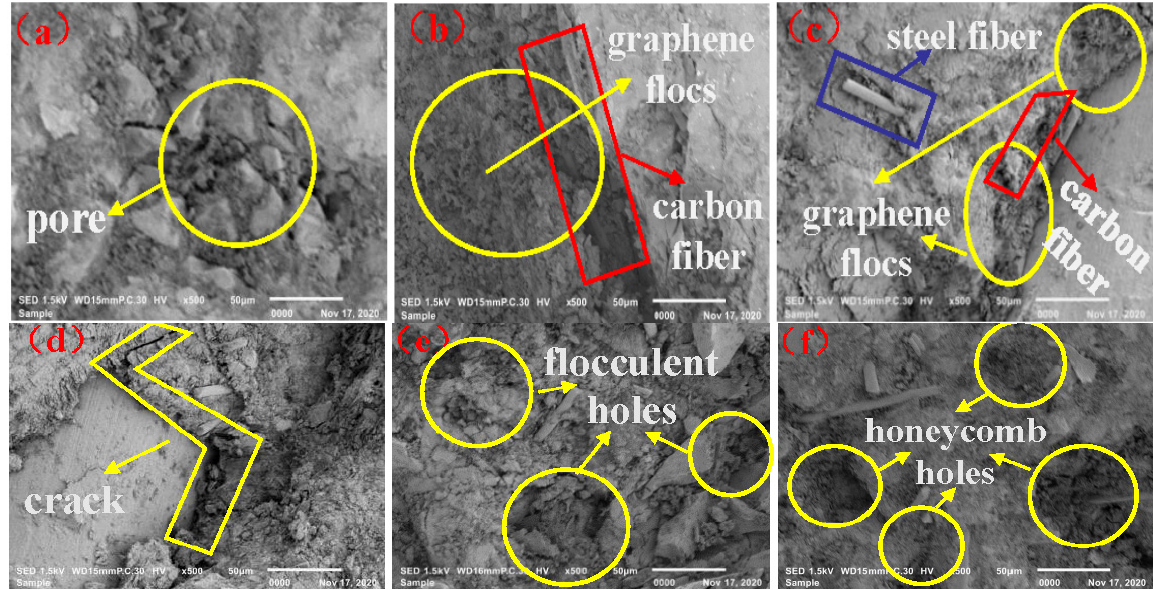
Figure 5. SEM test diagram of graphene composite conductive concrete with different graphene contents: ( a ) 0 wt.%, ( b ) 0.2 wt.%, ( c ) 0.4 wt.%, ( d ) 0.6 wt.%, ( e ) 0.8 wt.%, ( f ) 1.0 wt.%.